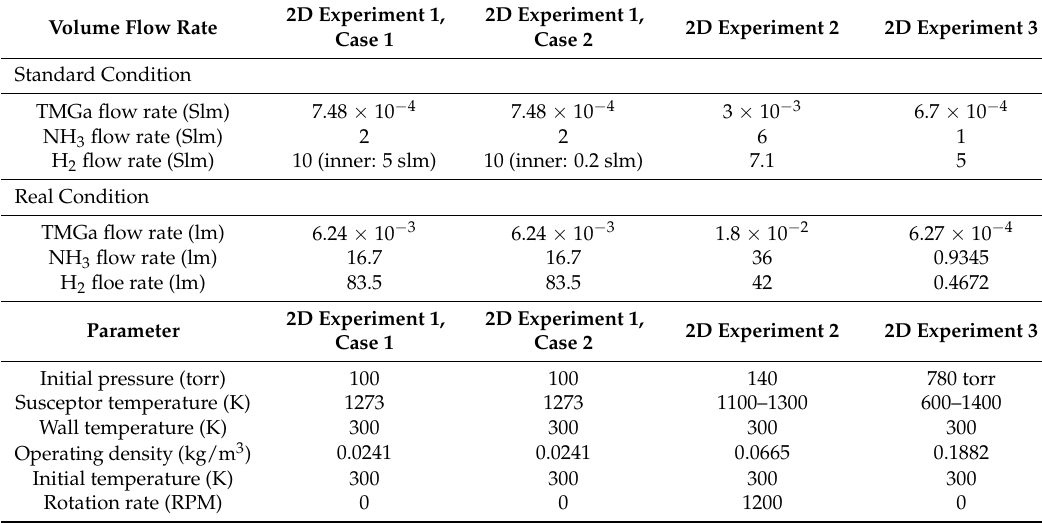
Table 7. Process parameters for 2D modeling.